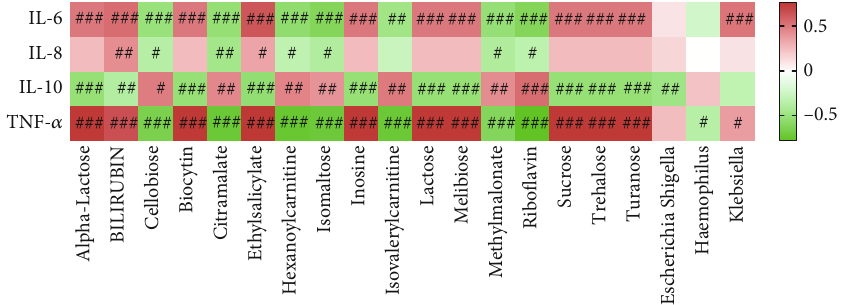
Figure 7: The correlation among gut microbiota, serum metabolites, and in fl ammatory factors. Red represents positive correlation, and green represents negative correlation. # P < 0 : 05 ; ## P < 0 : 01 ; ### P < 0 : 001